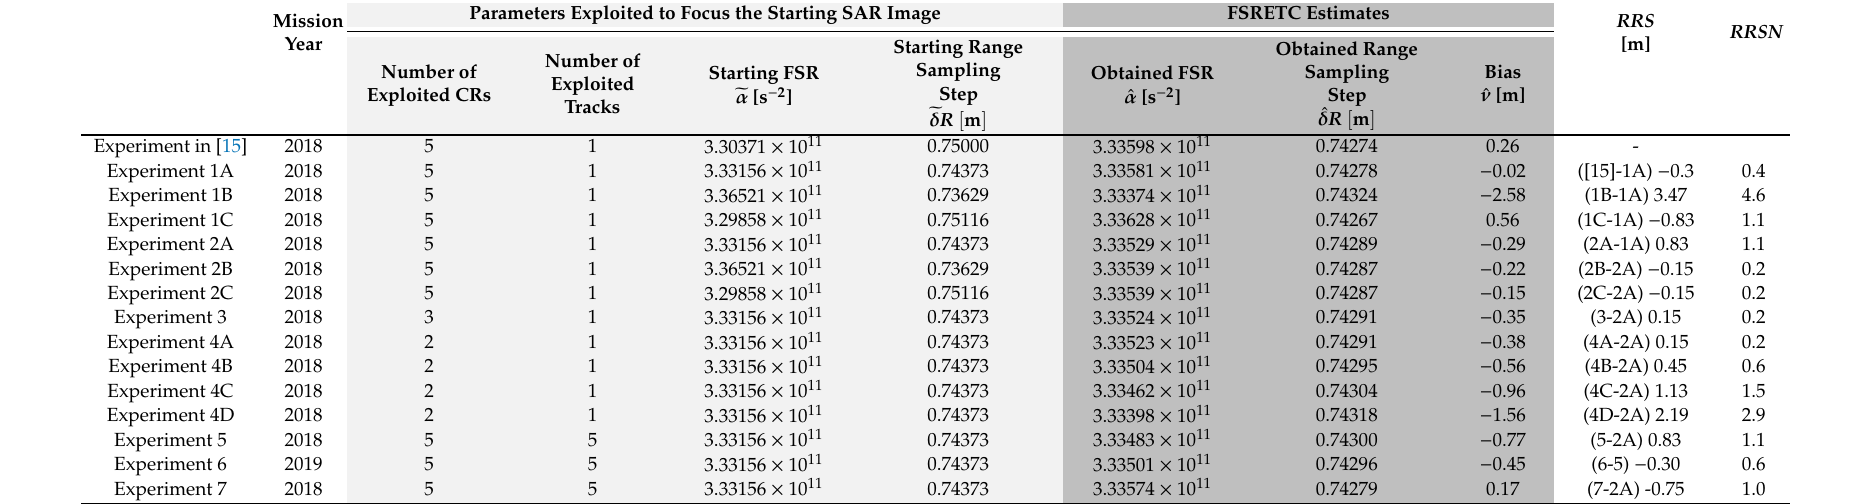
Table 3. Processing parameters and results of the considered